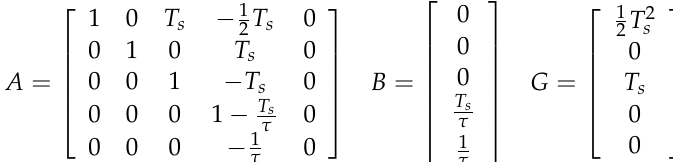
Figure 1. Schematic diagram of longitudinal kinematics. where x p is the target vehicle position, x f is the ACC vehicle position, and d is the actual relative distance between the two vehicles.